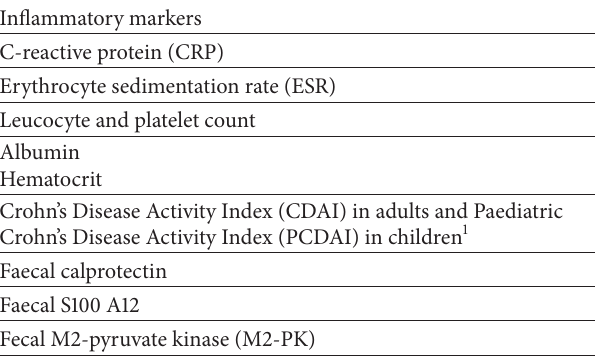
Table 1: Inflammatory markers used in the diagnosis of IBD. Inflammatory markers C-reactive protein